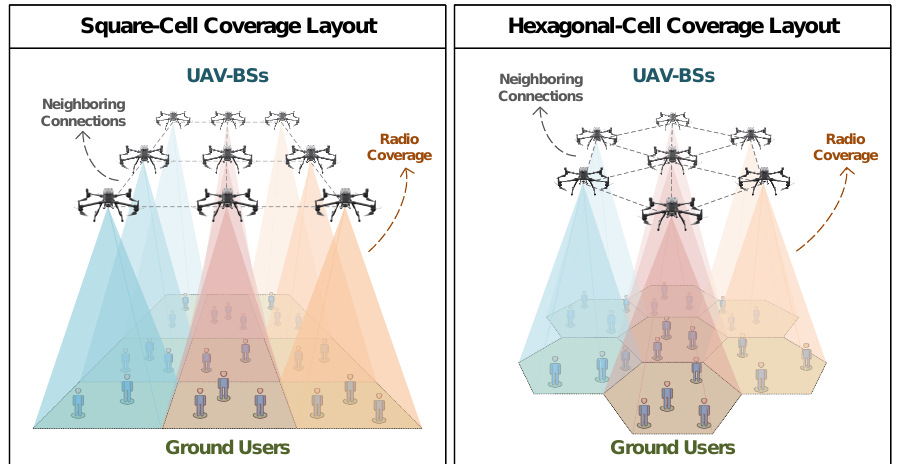
Figure 1. Two coverage layout scenarios of UAV-assisted ad hoc wireless networks. Each UAV-BS has a fixed serving area such that it can only serve the ground users within its radio coverage. Two typical coverage layouts are the square cell coverage-layout ( left ) and hexagonal cell coverage layout ( right